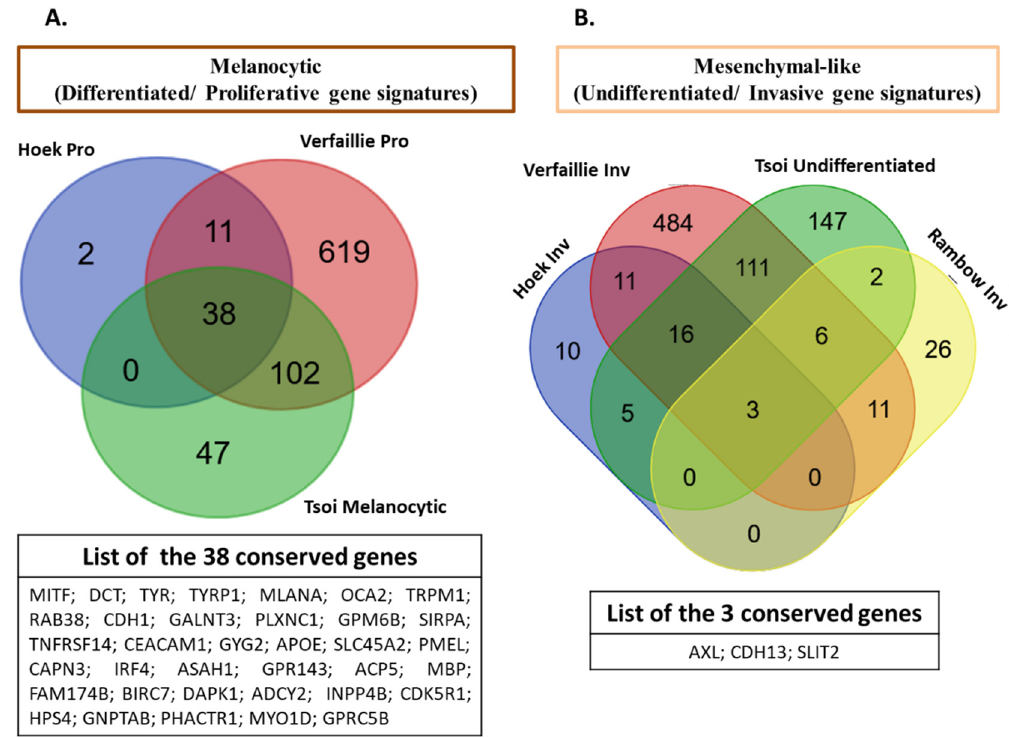
Figure 3. Comparison of melanoma signatures across different publications. Venn diagram (http://bioinformatics.psb.ugent.be/webtools/Venn/) showing the distribution of shared and special genes of main melanoma states across different publications ([5,7,25,43]): ( A ) the melanocytic (proliferative/differentiated) signatures (Hoek proliferative (Pro) [7], Verfaillie proliferative (Pro) [5], Tsoi melanocytic [25]), and a list of common genes among these signatures. ( B ) The mesenchymal-like (invasive/undifferentiated) signatures (Hoek invasive (Inv) [7], Verfaillie invasive (Inv) [5], Tsoi undifferentiated [25], Rambow invasive (Inv) [43]), and the list of common genes among these signatures.